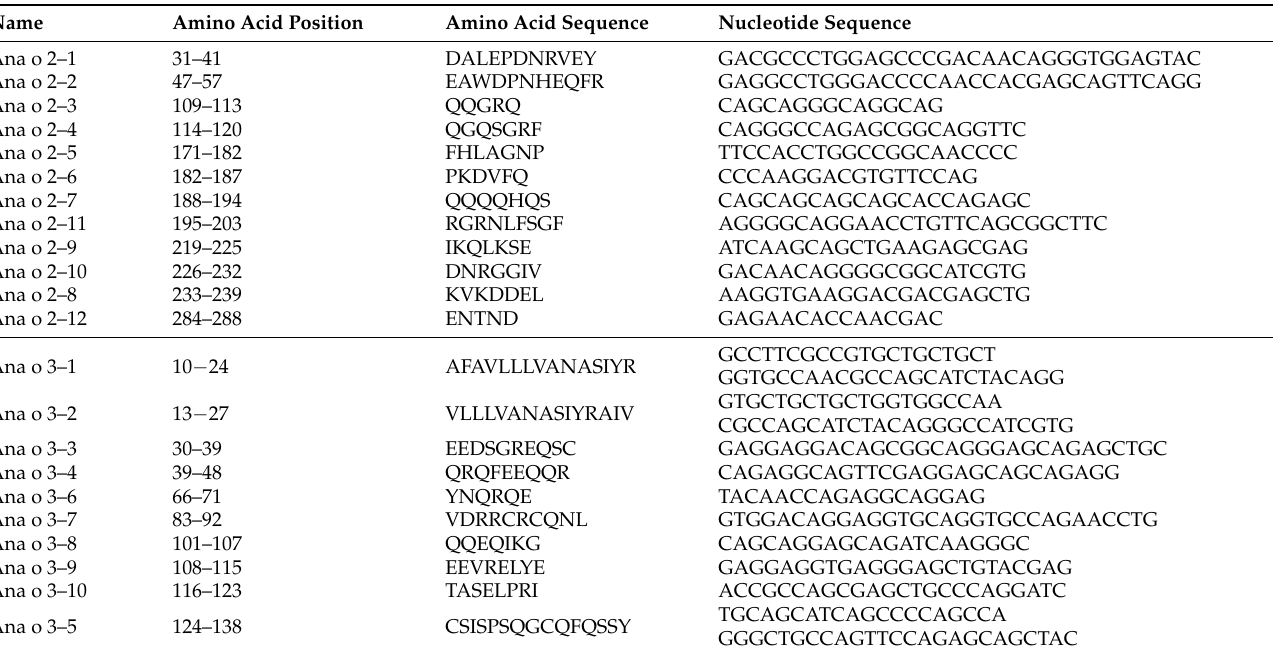
Table 1. Peptide sequences of the predicted epitopes and the corresponding nucleotide sequences.